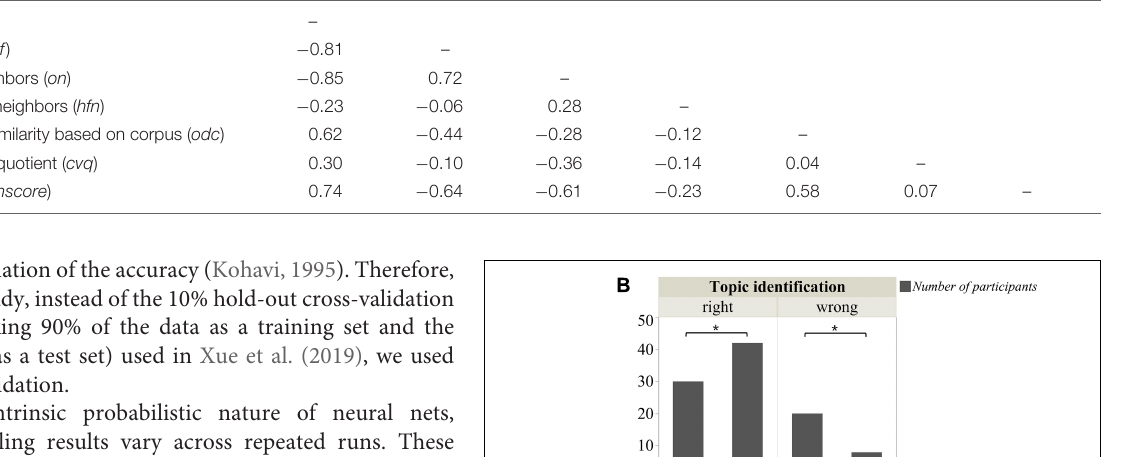
TABLE 2 | Correlations between the seven psycholinguistic features. Variables